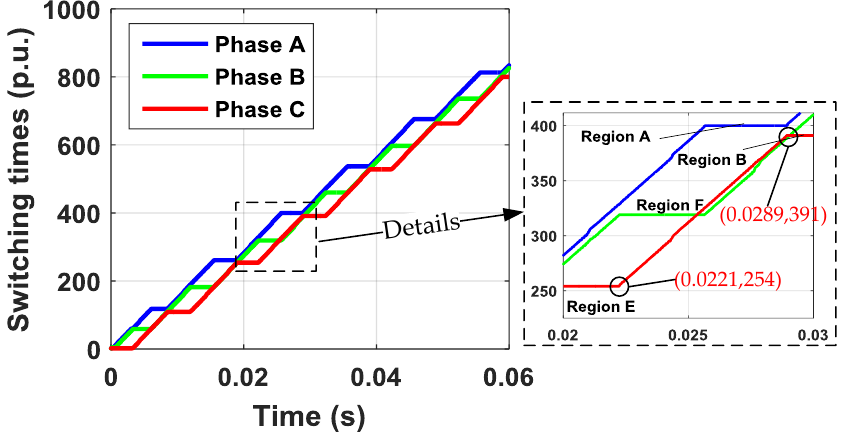
Figure 16. ST-FHCC performance.